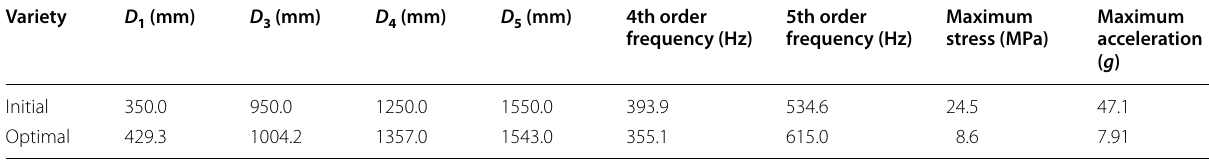
Table 6. Optimization